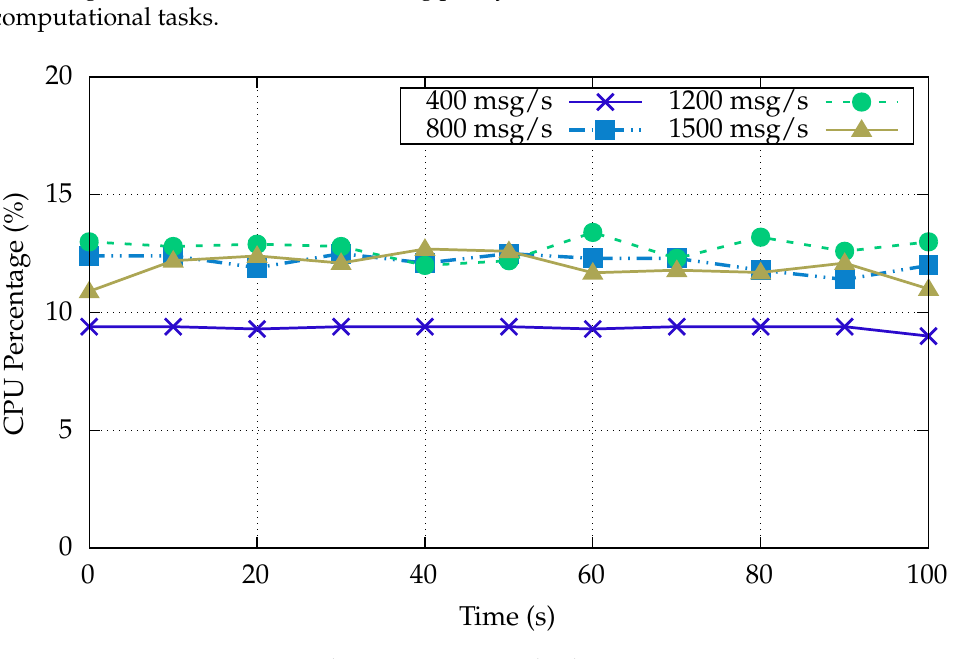
Figure 5. Gateway CPU usage under varying message